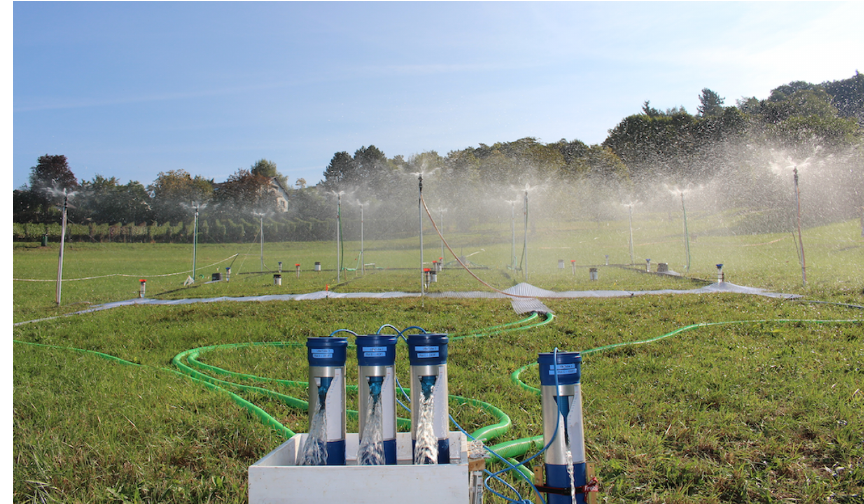
Figure 3. Exemplary setup of the field experiments. The foreground shows the measurement device for surface and subsurface runoff and the connecting lines (green hoses) from the trench covered with plastic sheets. Visible in the background is the actual experimental plot divided into the three subplots with rainfall gauges and the sprinkling